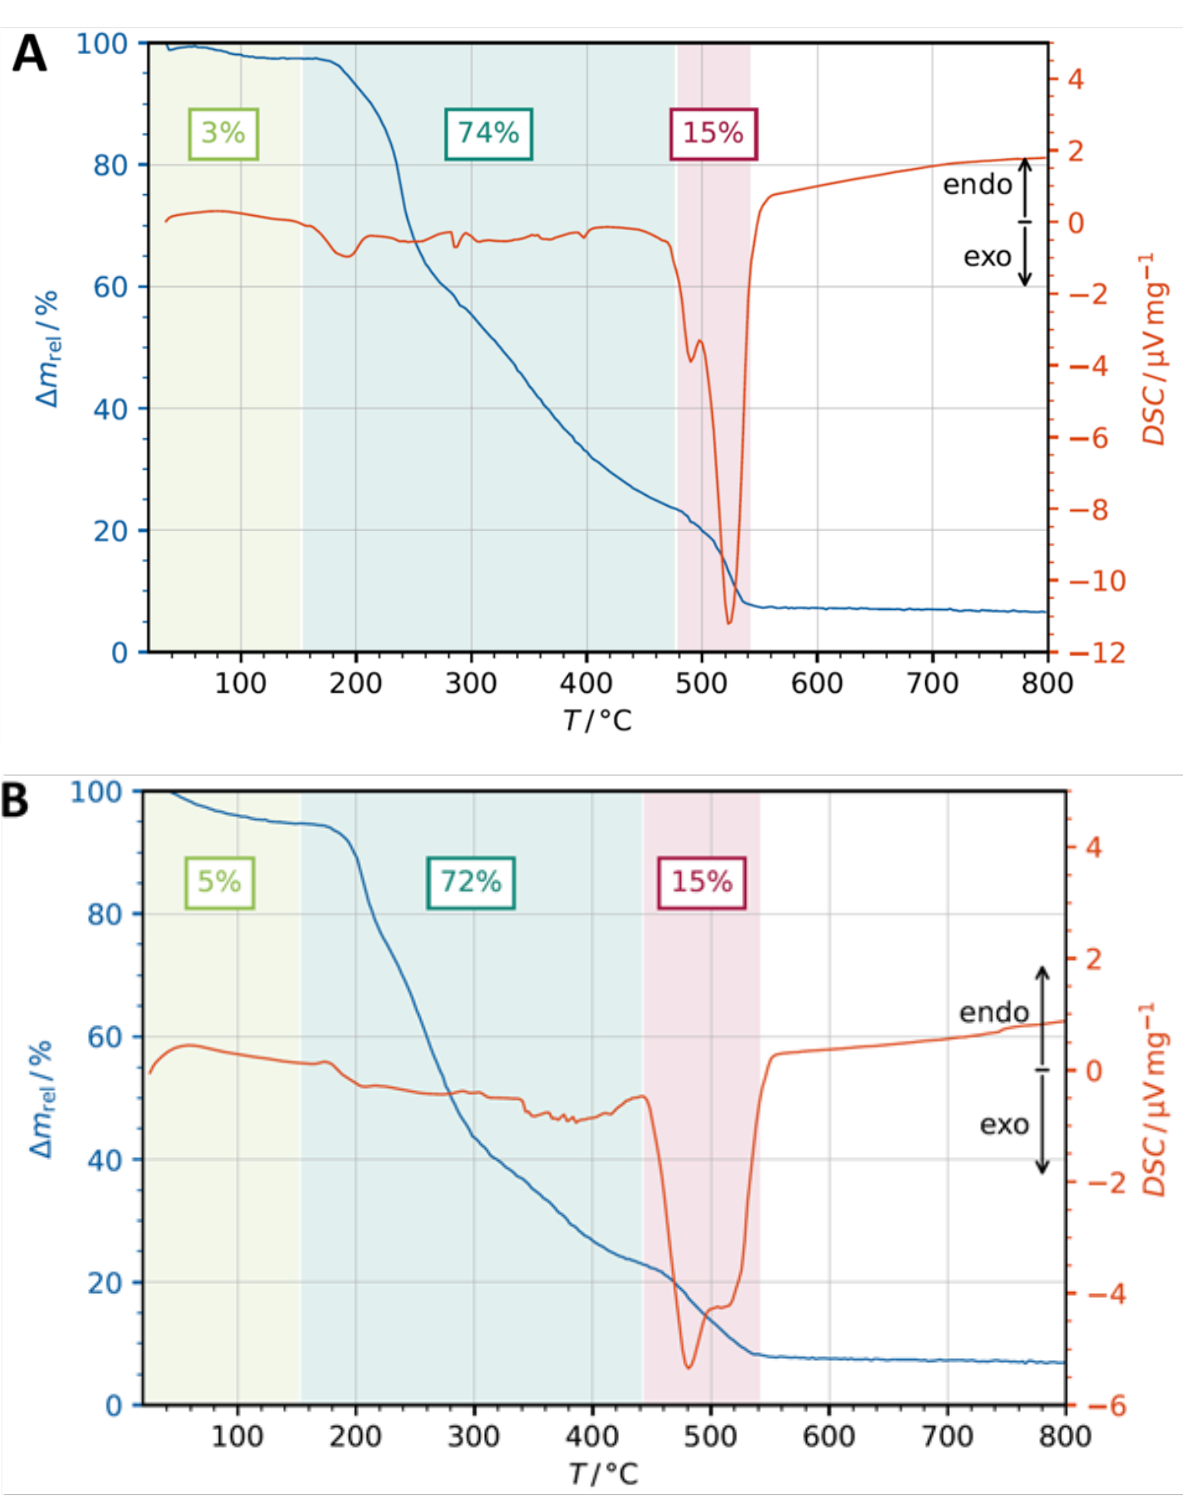
Figure 3. DSC and mass loss profiles of ( A ) Sal-Mn(II) and ( B ) Sal-Gd(III) complexes.